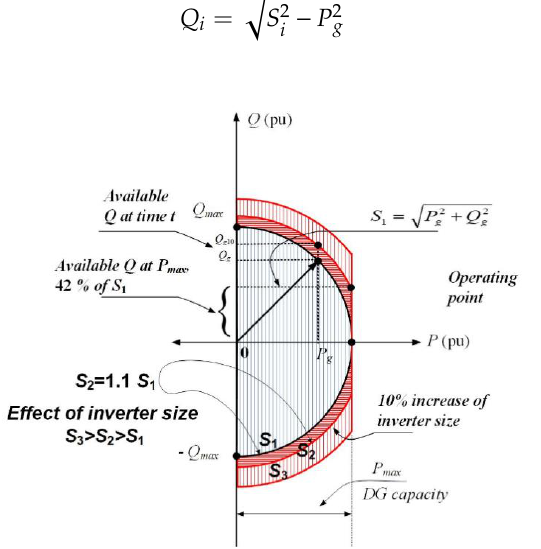
Figure 3. Reactive power control capability of inverter-based energy systems.